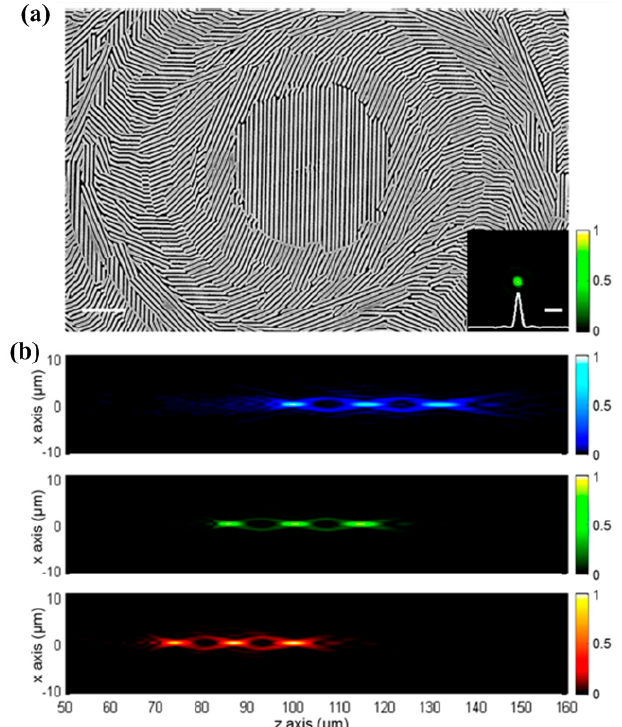
Figure 5. ( a ) SEM topography of the interleaved metasurface containing various sub-elements. ( b ) Measured transmitted intensity profiles for blue, green, and red colors. Reproduced with permission from [123]. Copyright American Chemical Society, 2016.